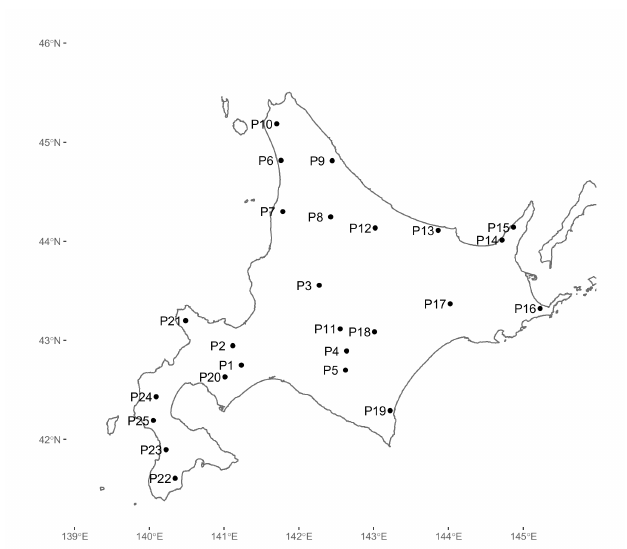
Figure 1. Locations of the 25 natural populations of Abies sachalinensis used in this study. Table 1. Study sites of Abies sachalinensis populations in Hokkaido, northern